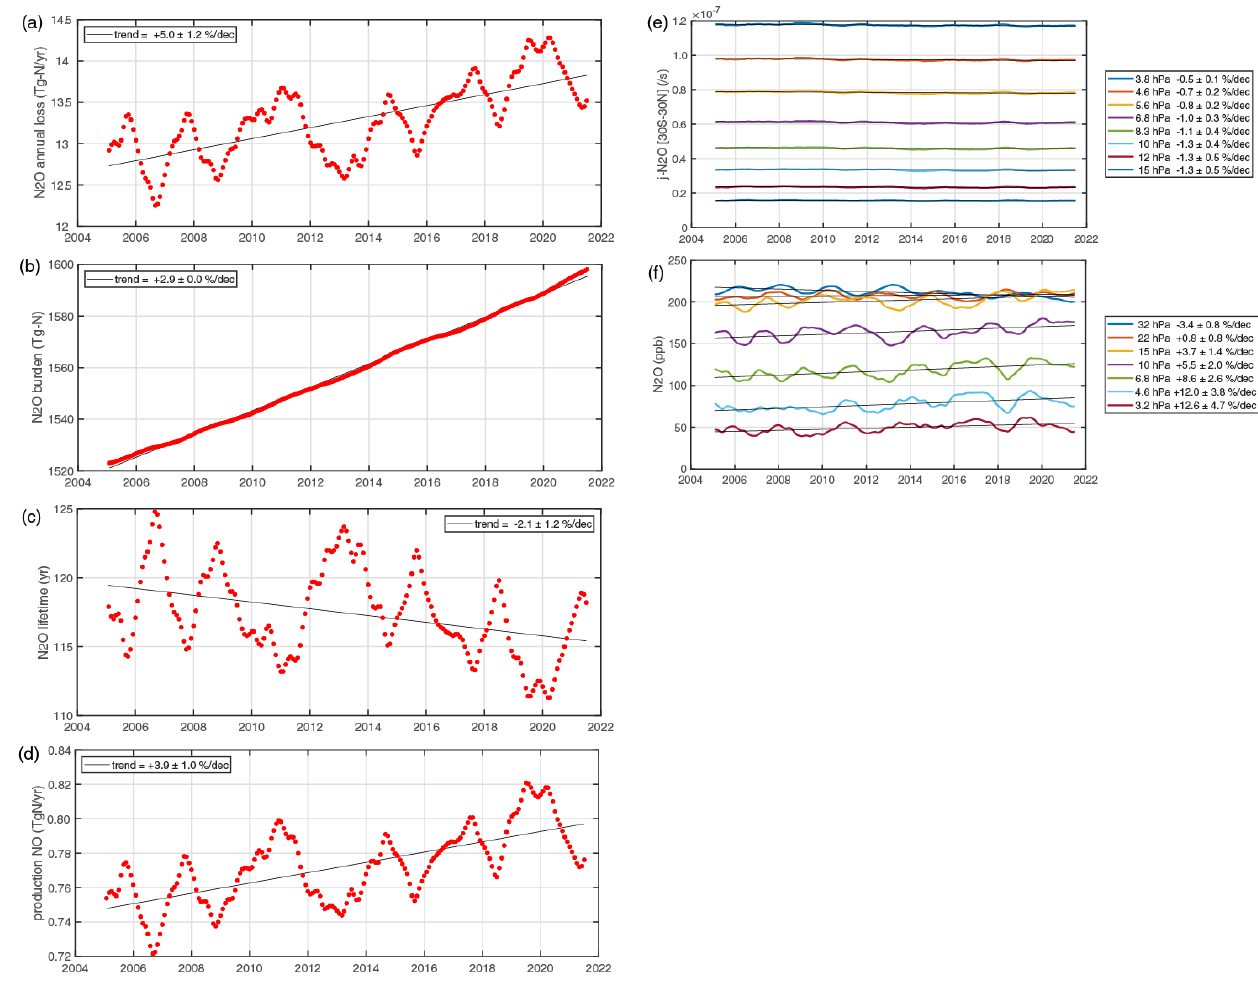
Figure 1. (a) N 2 O loss rate (TgNyr − 1 ) as monthly values of a 12-month running mean. The 198 red points begin with the 12-month average of August 2004 through July 2005 plotted as 1 February 2005 with the final point being 1 July 2021 (all of 2021). The thin black trend line shows the slope and uncertainty in the legend; see the text. (b) N 2 O global burden (TgN) based on marine surface observations. (c) N 2 O lifetime derived from the burden divided by loss rate. Production of NO (TgNyr − 1 ) from N 2 O loss. (e) Stratospheric photolysis rates, J-N 2 O (/s), at the standard MLS V5 T pressure levels (see legend) and averaged over 30 ◦ S–30 ◦ N. (f) N 2 O abundance (ppb) at the standard V5 N 2 O pressure levels (see legend) and averaged over 30 ◦ S–30 ◦